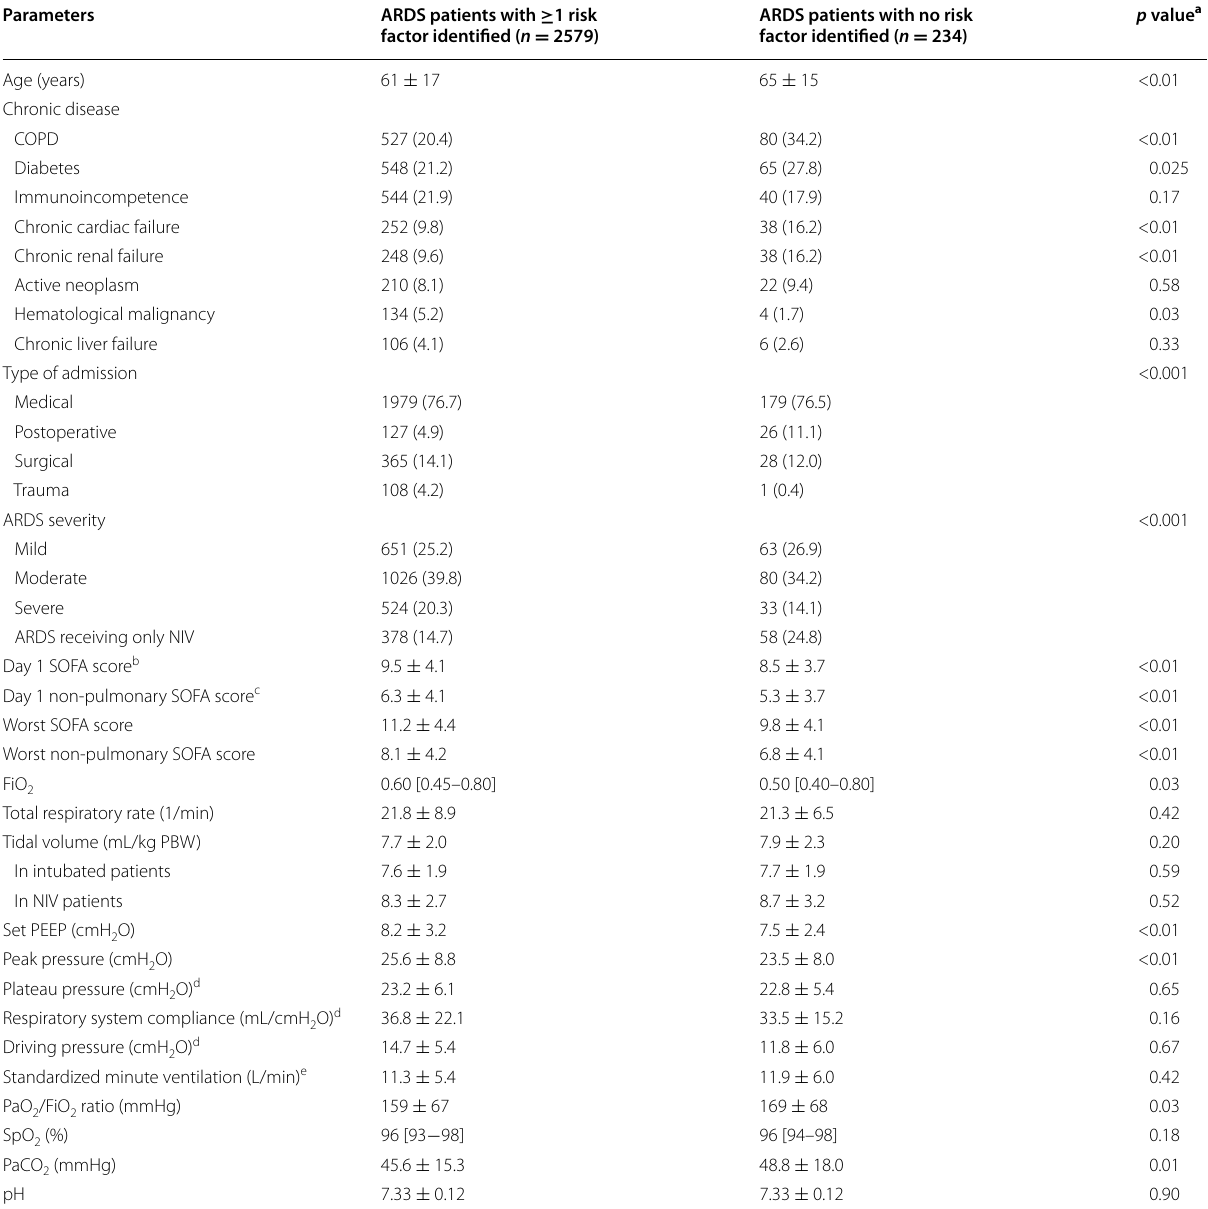
Table 1 Baseline characteristics of patients with ARDS meeting ARDS criteria within 48 h of acute hypoxemic respiratory failure onset ( n =